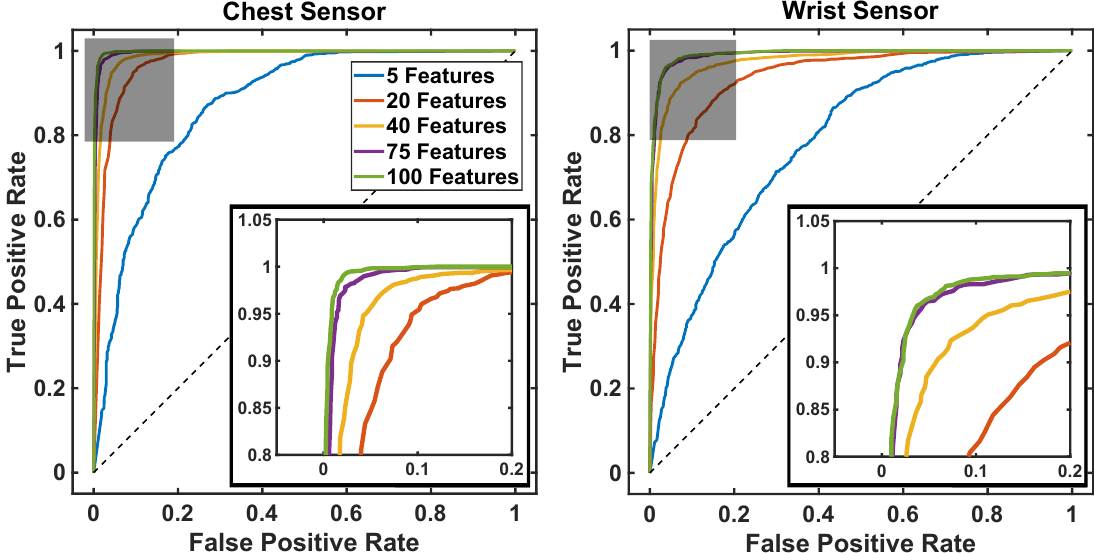
Figure 6. ROC curves for different numbers of data features used as input to the proposed machine learning-based algorithms.